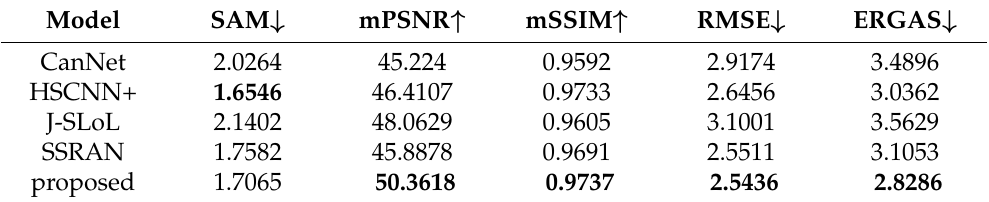
Table 3. Quantitative results of different methods using the Indian Pines dataset. “ ↓ ” means smaller is better for this index. “ ↑ ” means bigger is better for this